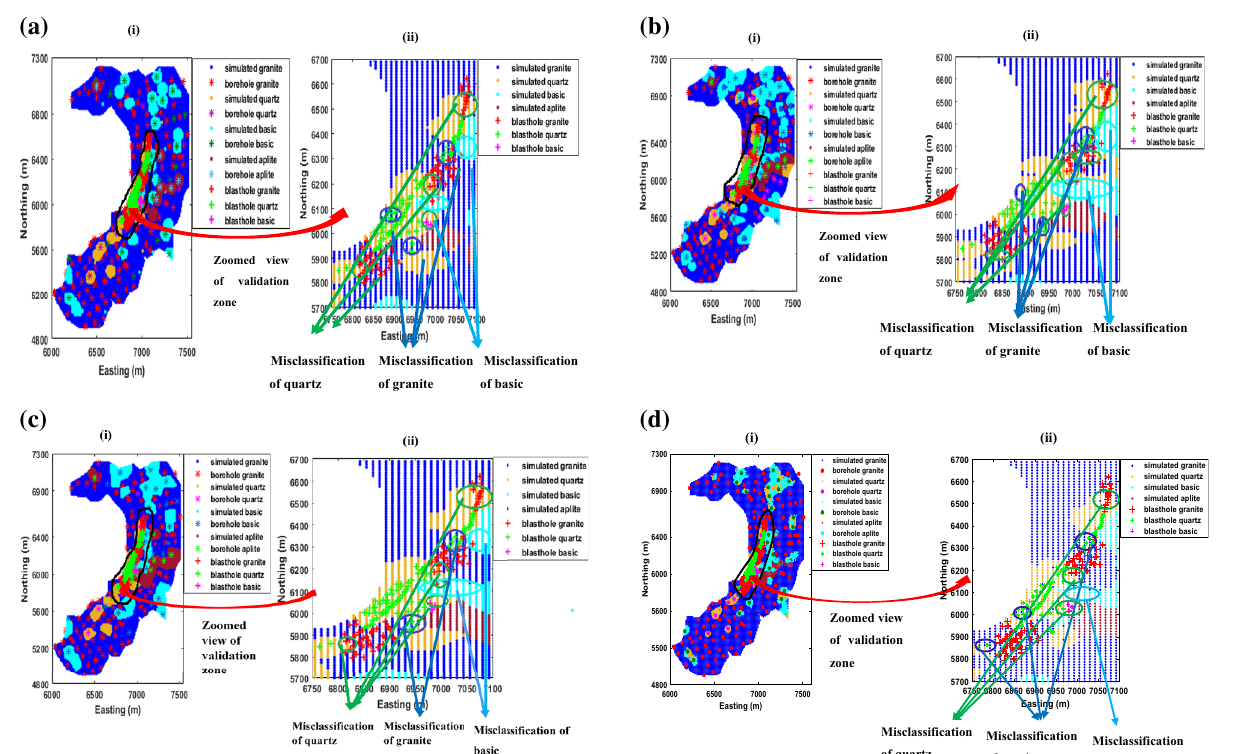
Figure 12. ( a ) MPL maps using Gaussian copula-based simulation. Locations of (i) simulated values, drill holes and blast-holes of bench at 448 m AMSL, (ii) Zoomed view of simulated values and blast-holes of the validation zone of Gaussian copula. ( b ) MPL maps using t copula-based simulation. Locations of (i) simulated values, drill holes and blast-holes of bench at 448 m AMSL, (ii) Zoomed view of simulated values and blast-holes of the validation zone of t copula. ( c ) MPL maps using v-transformed copula-based simulation. Locations of (i) simulated values, drill holes and blast-holes of bench at 448 m AMSL, (ii) Zoomed view of simulated values and blast-holes of the validation zone of v-transformed copula. ( d ) MPL maps using sequential indicator simulation. Locations of (i) simulated values, drill holes and blast-holes of bench at 448 m AMSL, (ii) Zoomed view of simulated values and blast-holes of the validation zone of sequential indicator